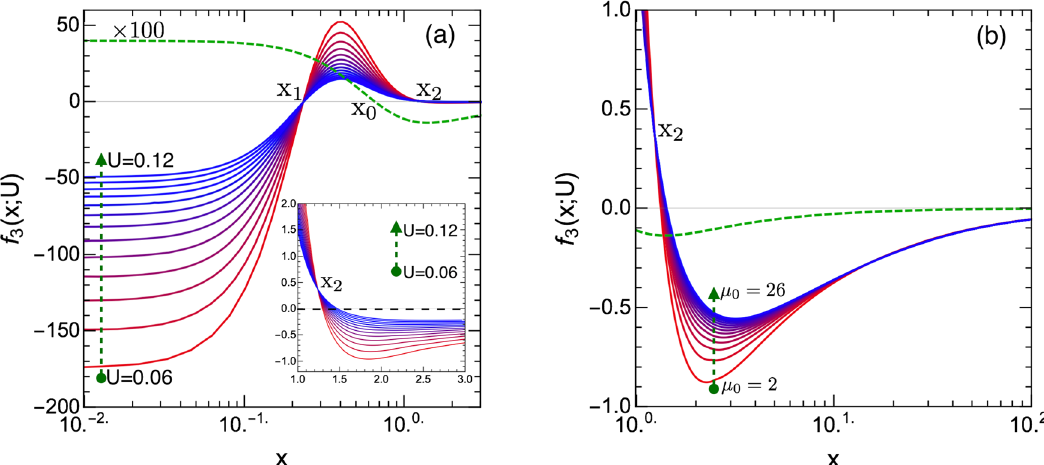
Fig. 2 Nonlinear dc conductivity in 2D Dirac materials. Characteristic nonlinear transport function f 3 versus the dimensionless parameter x = μ / Γ ( μ ) within the many-body conserving scheme. Also shown is f 3 for the phenomenological model (dashed green line). Curves of f 3 versus x are plotted for different U ’ s in the quantum regime ( a ), and for different μ 0 ’ s in the Boltzmann regime in THz unit ( b